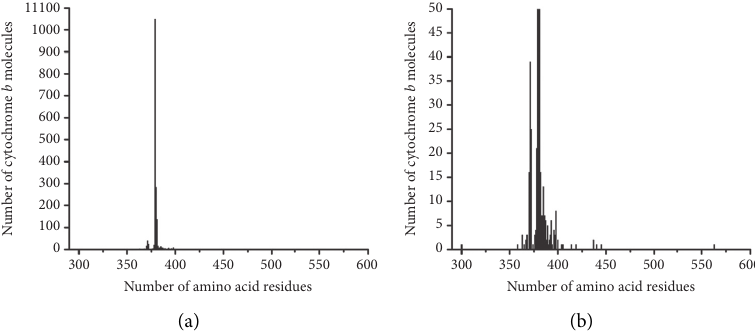
Figure 1: Distribution of the number of all identified cytochrome b molecules, according to data from the Swiss-Prot database on the number of amino acid residues. (a) Data at the ordinate, illustrating the entire maximum peak of the distribution. (b) The same data with a truncated ordinate and the same abscissa to identify all small Table 1: Content of the number of cytochrome b amino acid sequences in the swiss-prot database in various biological domains. Biological domains Number of molecules Number of amino acid residues